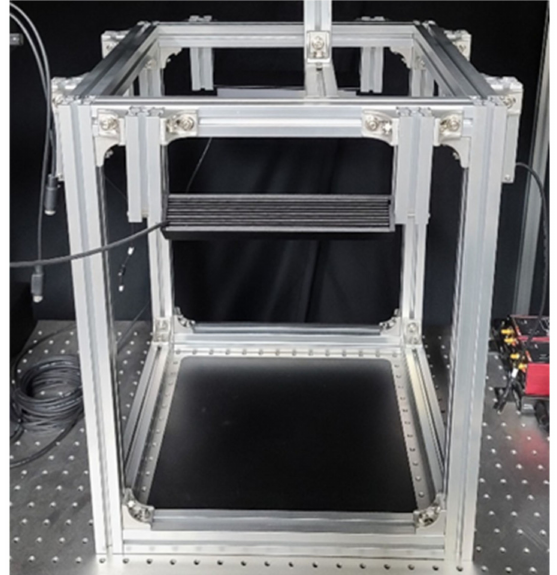
Figure 2. Trap photographing